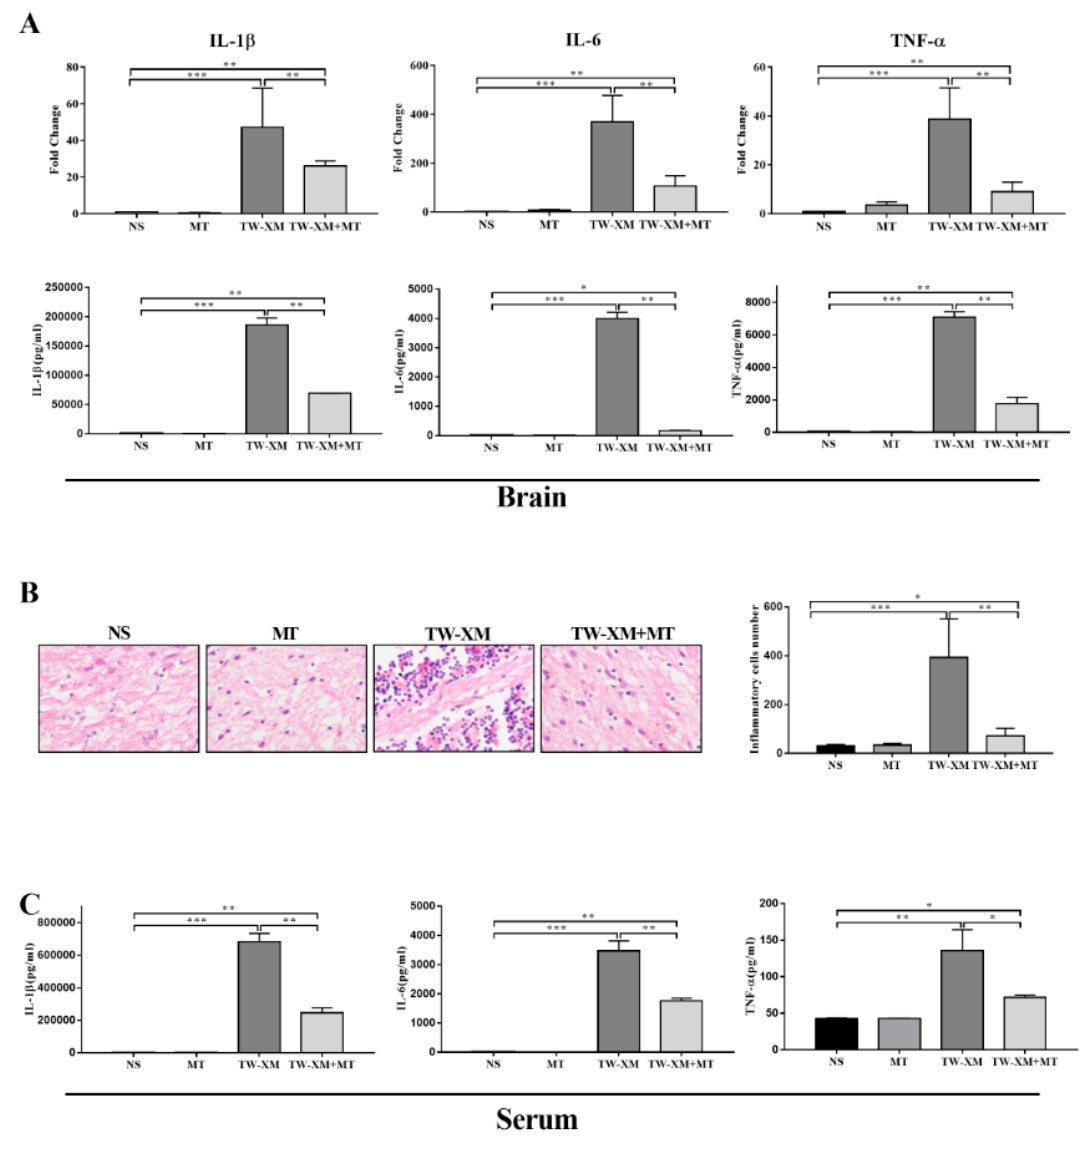
Figure 3. The effect of melatonin on the inflammatory response of brain and serum and the infiltration of neutrophils in the brain in APEC TW − XM − infected mice. ( A ) The mRNA expression and production of inflammatory factors in brain tissues of mice in each group by qPCR. ( B ) The infiltration of neutrophils in the brain was analyzed qualitatively and quantitatively by hematoxylin–eosin staining (bar = 100 µ m). ( C ) The production of inflammatory factors in serum of mice in each group by ELISA. All data were determined by one-way ANOVA and expressed as means ± SEM. * p < 0.05, ** p < 0.01, *** p < 0.001,.